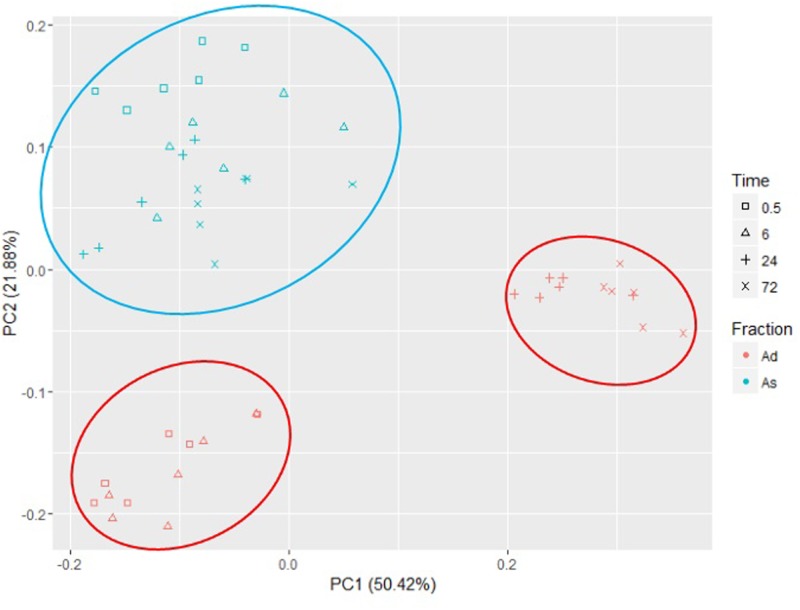
Principal component analysis of bacteria loosely (As) and tightly (Ad) attached to rice straw after 0.5, 6, 24, and 72 h incubation in the rumen of cows by Illumina MiSeq sequencing of 16S rRNA gene (n = 6).